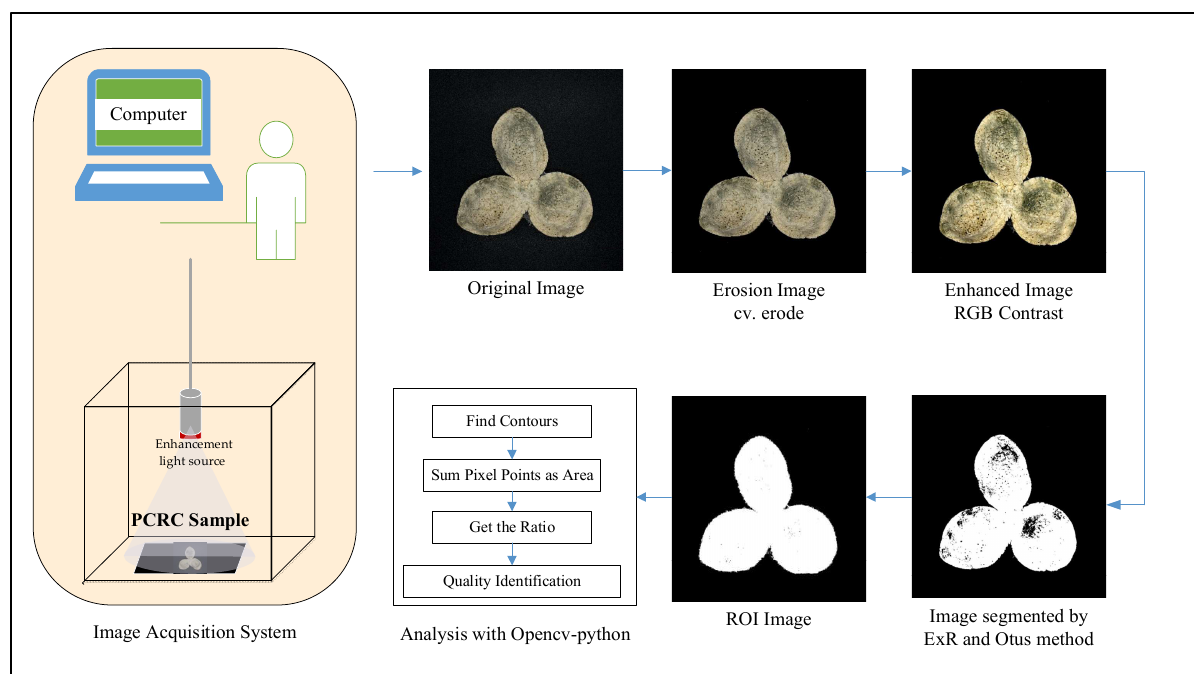
Figure 7. The structure of PCRC identification.